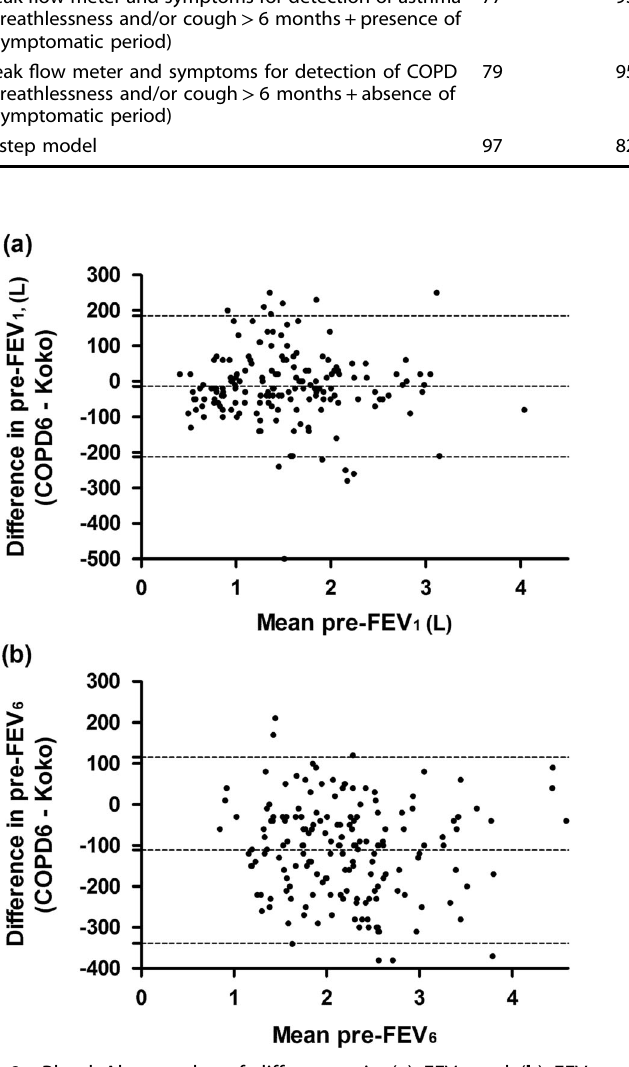
Fig. 3 Bland – Altman plot of differences in ( a ) FEV 1 and ( b ) FEV 6 measured by COPD6 device and Koko spirometer